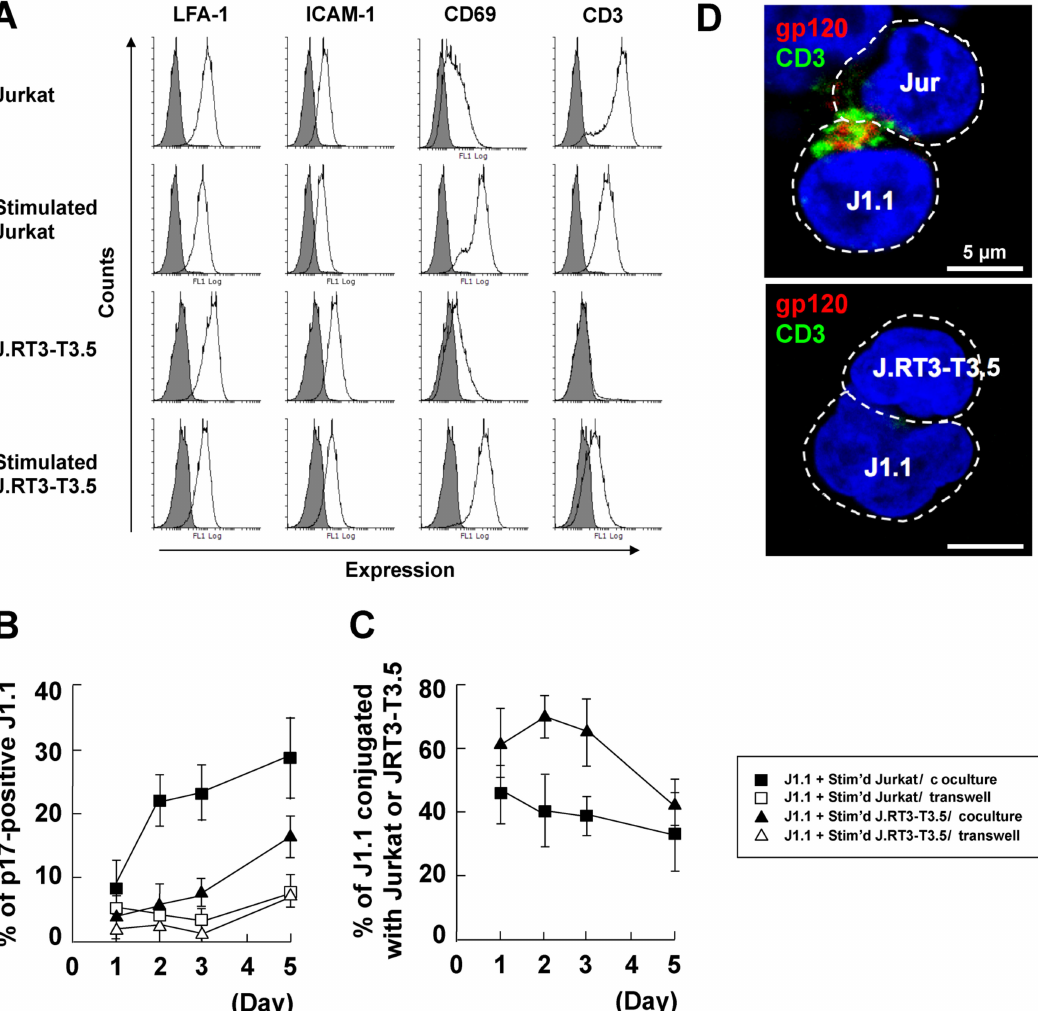
Figure 5. Reactivation of HIV-1 in J1.1 cells by coculture with CD3-deficient Jurkat cells. ( A ) Expression of LFA-1, ICAM-1, CD69, and CD3 on the cell surface. The cell surface of Jurkat (stimulated and unstimulated) and J.RT3-T3.5 (TCR β chain-deficient Jurkat) (stimulated and unstimulated) was immunostained with anti-LFA-1 α , anti-ICAM-1, anti-CD69, and anti-CD3 ε mAbs. Gray-shaded histograms show the negative controls. For comparison, the FCM data on LFA-1, ICAM-1, and CD69 expression on Jurkat cells (in Figure 3a) were shown. ( B , C ) J1.1 cells were cocultured with stimulated Jurkat or J.RT3-T3.5 cells with cell-to-cell contact. J1.1 cells were similarly cocultured with stimulated Jurkat or J.RT3-T3.5 cells without cell contact. ( B ) Reactivation e ffi ciency of latent HIV-1 in the J1.1 cells. The cells were immunostained with anti-HIV-1 p17MA mAb. The rates of p17MA-positive J1.1 cells in 100–150 J1.1 cells were calculated as described in Figure 1. Data are the mean ± SD from three independent experiments. ( C ) Conjugation e ffi ciency of J1.1 with stimulated Jurkat or J.RT3-T3.5 cells. The rates of J1.1 conjugated with Jurkat or J.RT3-T3.5 cells in 100–150 J1.1 cells were calculated as described in Figure 1. Data are the mean ± SD from three independent experiments. ( D ) J1.1 cells were prelabeled with CellTracker and were cocultured with stimulated Jurkat or J.RT3-T3.5 cells with cell contact. At 3 days post coculture, the cells were immunostained with anti-HIV-1 gp120 Ab (red) and anti-CD3 ε mAb (green). Representative images were shown. Scale bar, 5 µ